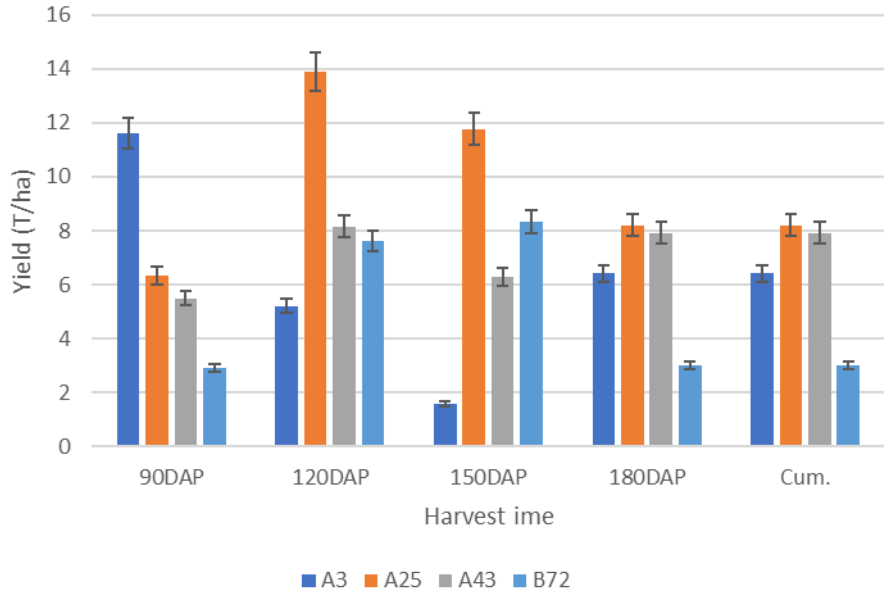
Figure 2. Growth pattern for discontinuous storage root formation and bulking (DCSRFAB) of four sweetpotato genotypes representing different growth patterns over four harvest times (averaged across four environments). Growth trend for genotypes A3, A25, A43 and B72 showing a fully DCSRFAB trait which generally increases the yield up to 120 days after planting (DAP) and then decreases overtime. The cumulative yield is generally lower than the maximum yield due to the yield decreasing in late stages. Note: DAP = days after planting, Cum. = cumulative